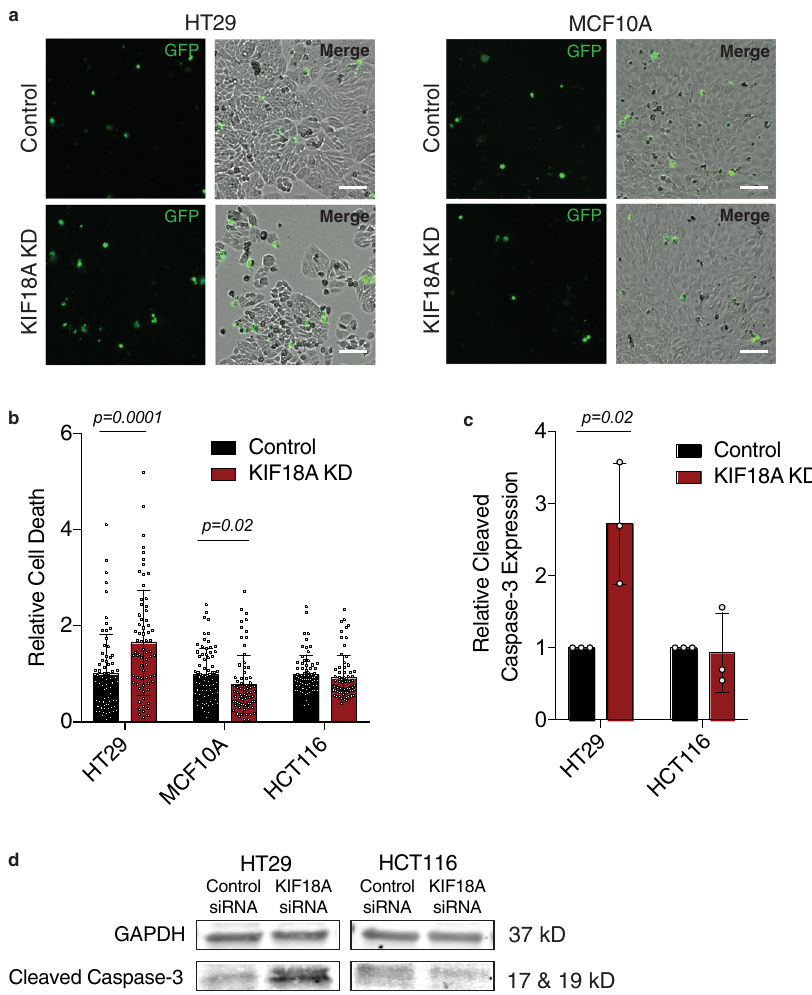
Fig. 2 KIF18A depletion increases cell death in CIN cells. a Representative images (from three independent experiments) of HT29 and MCF10A cells labeled with Celltox Green cytotoxicity dye (green) 5 days after siRNA transfection. Scale bars are 100 microns. b Relative cell death calculated as the normalized ratio of the change in Celltox-stained cell density to the change in total cell density over 96 h. n (wells of cells/independent experiments) = 72/ 3 for MCF10A and 71/3 for HT29 and HCT116. c Relative expression of cleaved-caspase 3 measured via western blot for each condition. Results are from three independent experiments. d Western blot showing representative cleaved-caspase-3 (CC3) expression levels. All graphs show mean ± SD and individual data points. Data were analyzed by unpaired, two-tailed t test. P values <0.05 are